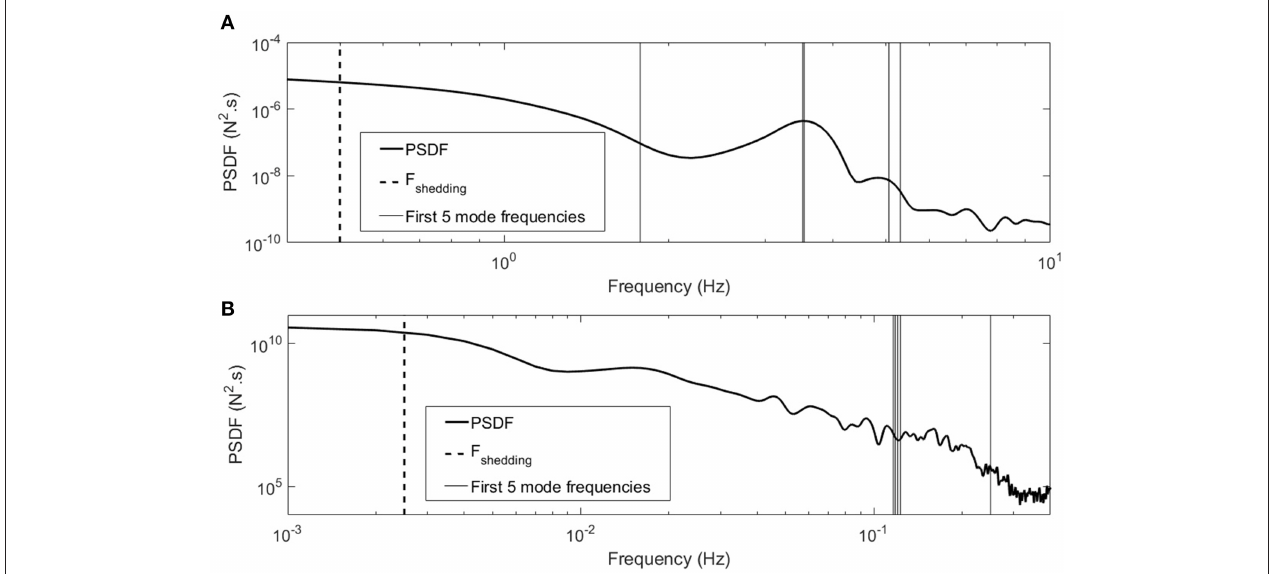
FIGURE 13 | Mode frequencies compared to shedding frequency for (A) model-scale and (B) full-scale.